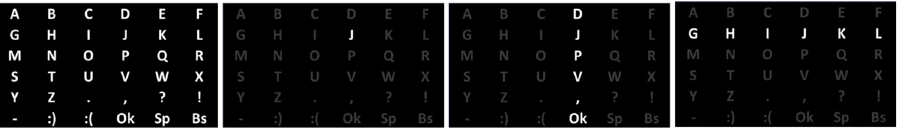
Fig 2. Two-dimensional row-column (2D-RC) based classical paradigm screen shots on LED